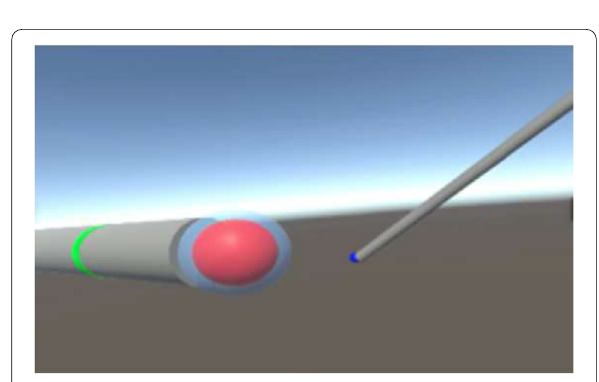
Fig. 14 3D image displayed subjects during the condition (b), (d), and